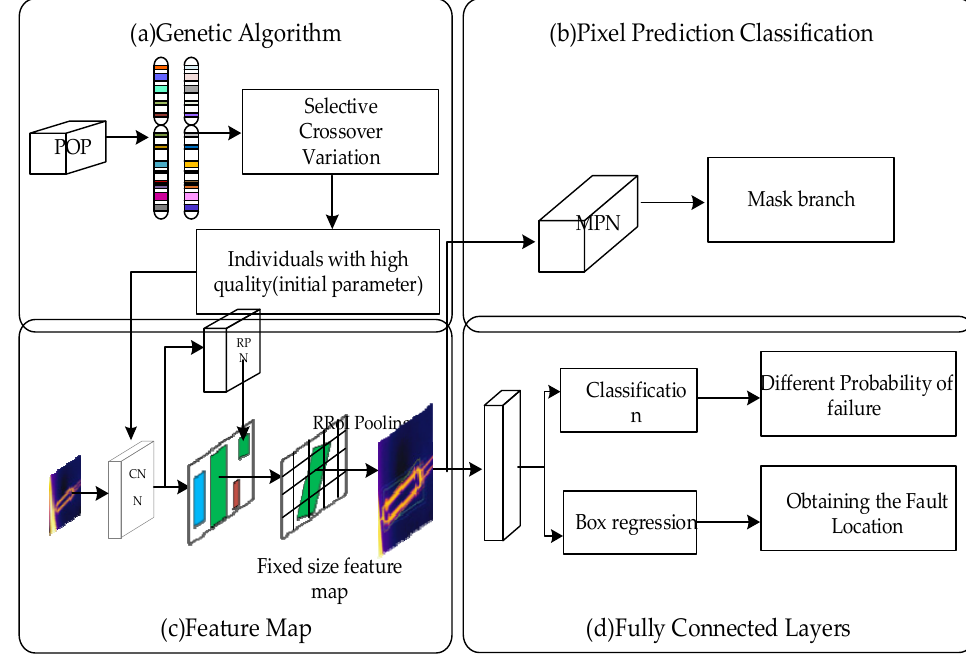
Figure 3. ARG-Mask RCNN framework.